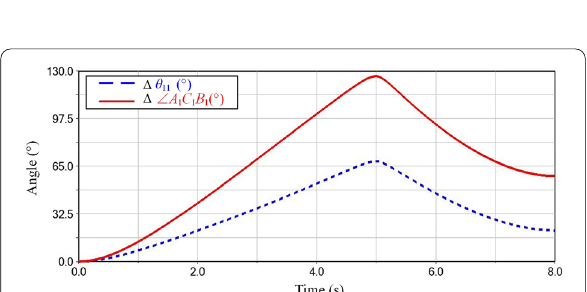
Figure 25 The variation of θ 11 and ∠ A 1 C 1 B 1 when the mechanism avoids singular position